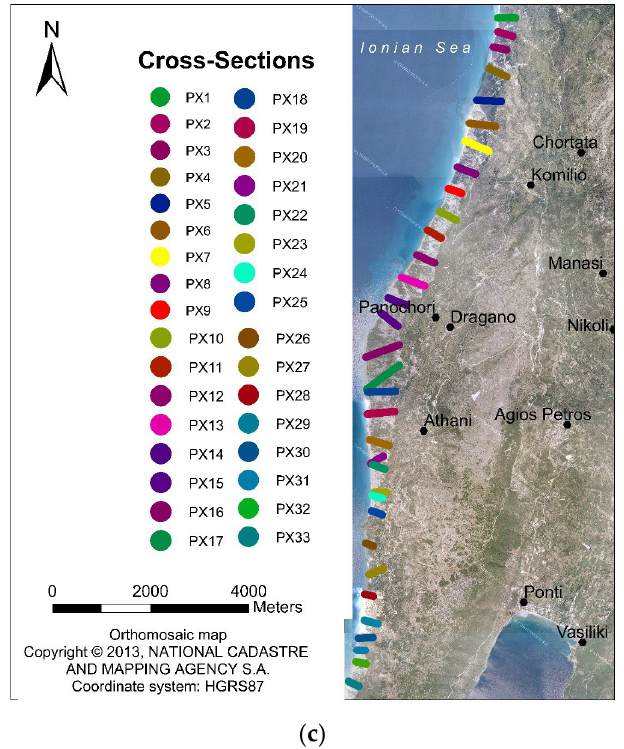
Figure 6. Location of the cross-sections (trajectories) for rockfall simulation in areas A, B, and C. ( a – c